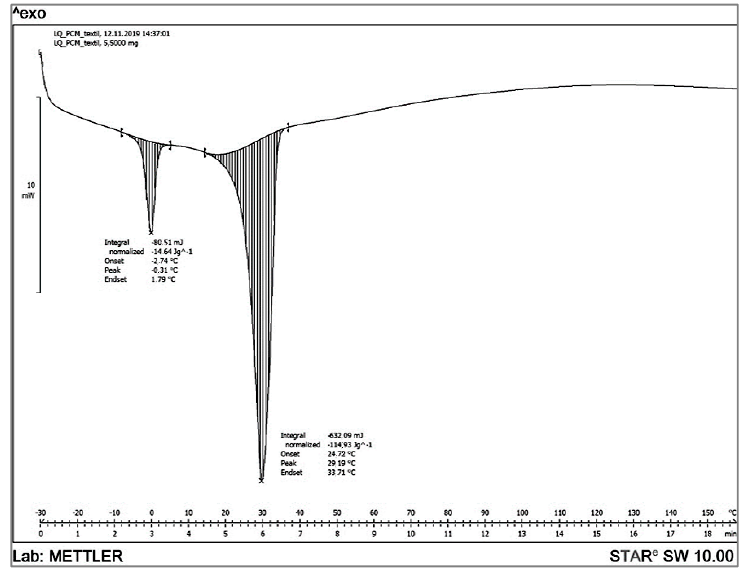
Figure 2. Differential Scanning Calorimetry (DSC) curve of Micronal ® DS 5001 X obtained using nitrogen at 50 mL/min as purge gas.